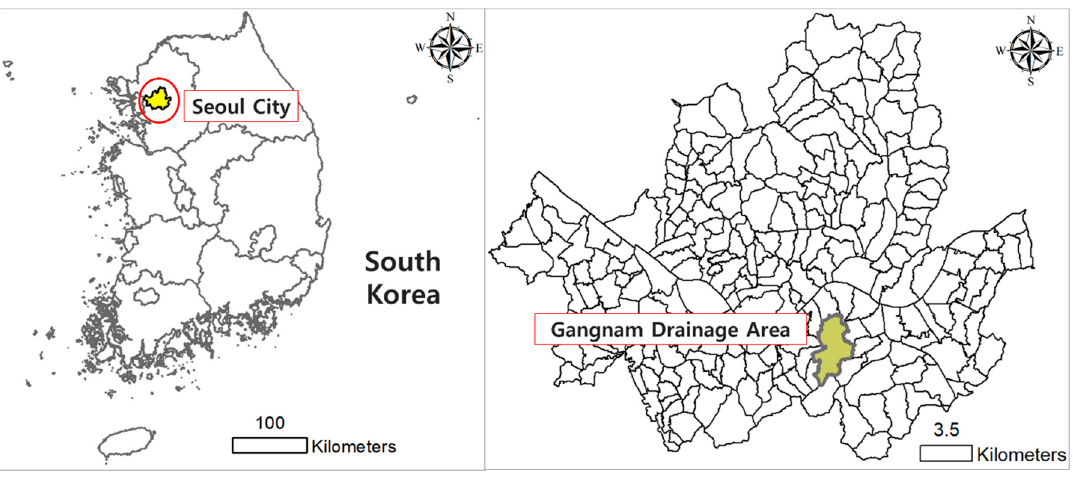
Figure . 1 Location of Study Area. Figure 1. Location of Study